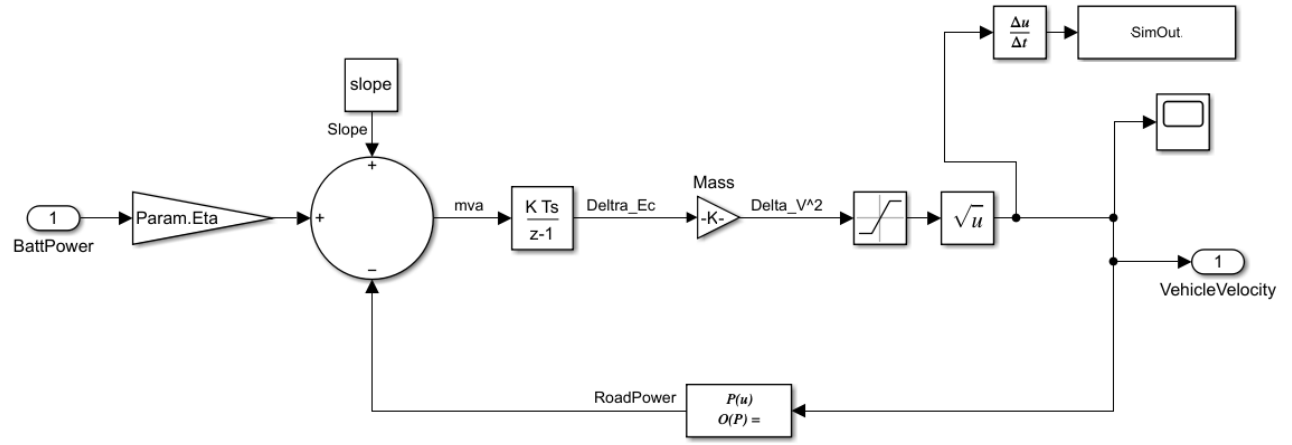
Figure 6. Longitudinal dynamics of two-wheeler block using through a physical-based energy approach on